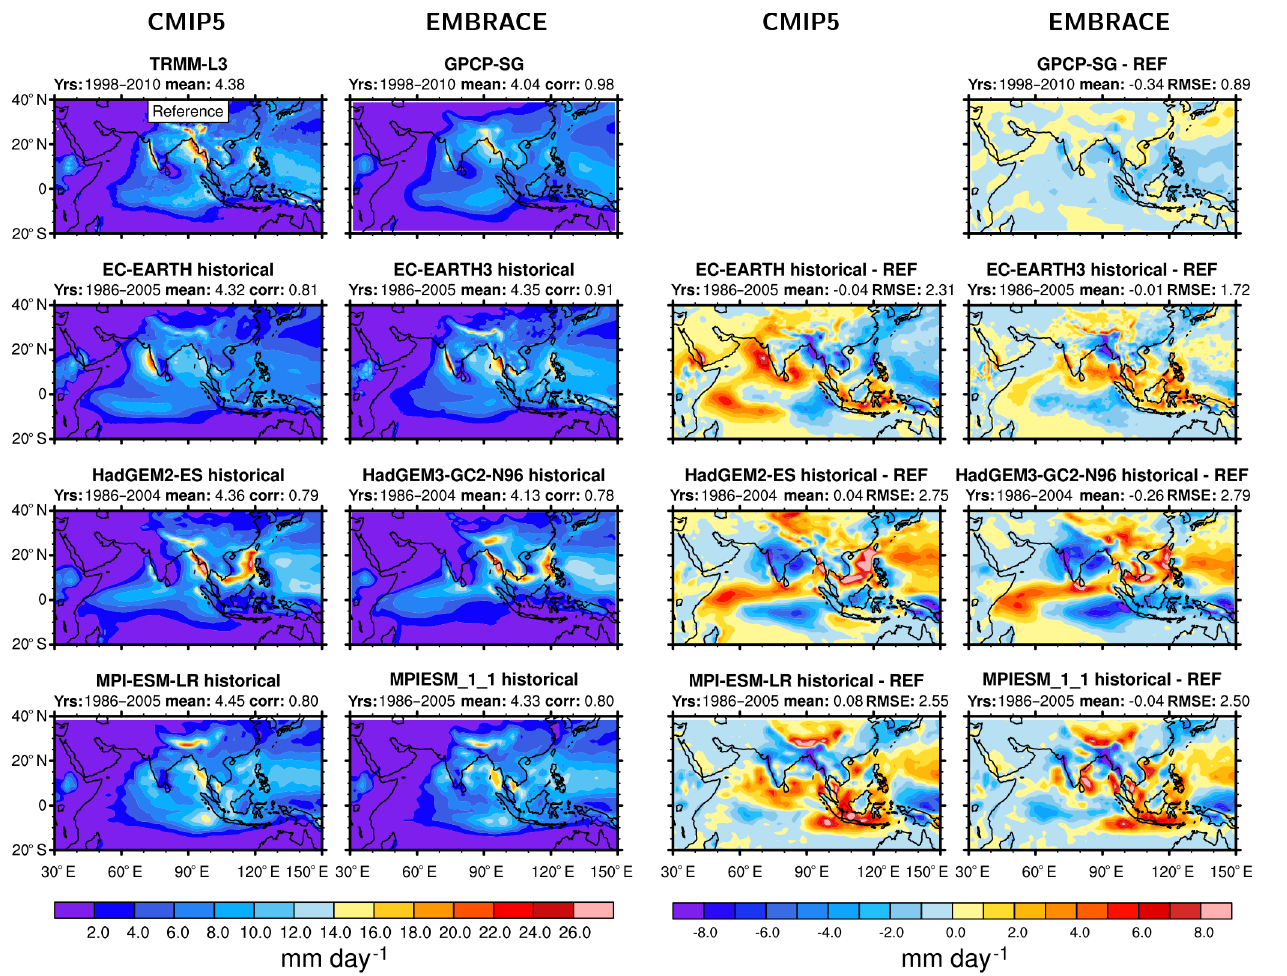
Figure 3. Leftmost two columns: seasonal mean precipitation for JJAS from observations (TRMM, GPCP) and the coupled simulations. The years used to calculate the averages shown are given above each panel (“yrs”). Rightmost two columns: differences relative to TRMM. Columns 1 and 3 show the original CMIP5 model versions, columns 2 and 4 the EMBRACE-updated models. The domain-averaged annual mean (“mean”), linear pattern correlation (“corr”; leftmost two columns), mean bias (“mean”), and root mean square error (RMSE; rightmost two columns) compared with TRMM are given above the individual